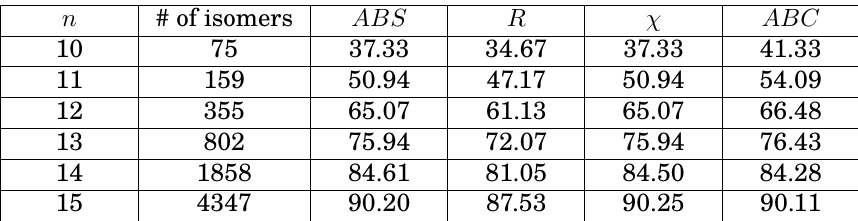
Table 3: The percentage of degeneracy of ABS , R , χ , and ABC indices in the case of chemical